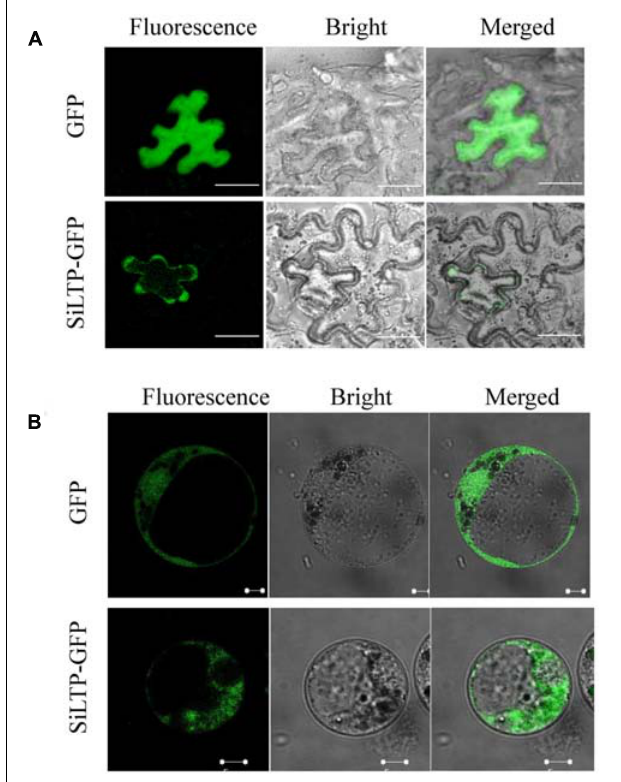
FIGURE 3 | Subcellular localization of SiLTP in tobacco epidermal cells (A) and maize protoplasts (B) . The green fluorescence signals, bright-field, and an overlay of the green fluorescence and bright-field images are shown from left to right. (A) Bar = 50 µ m; (B) bar = 5 µ